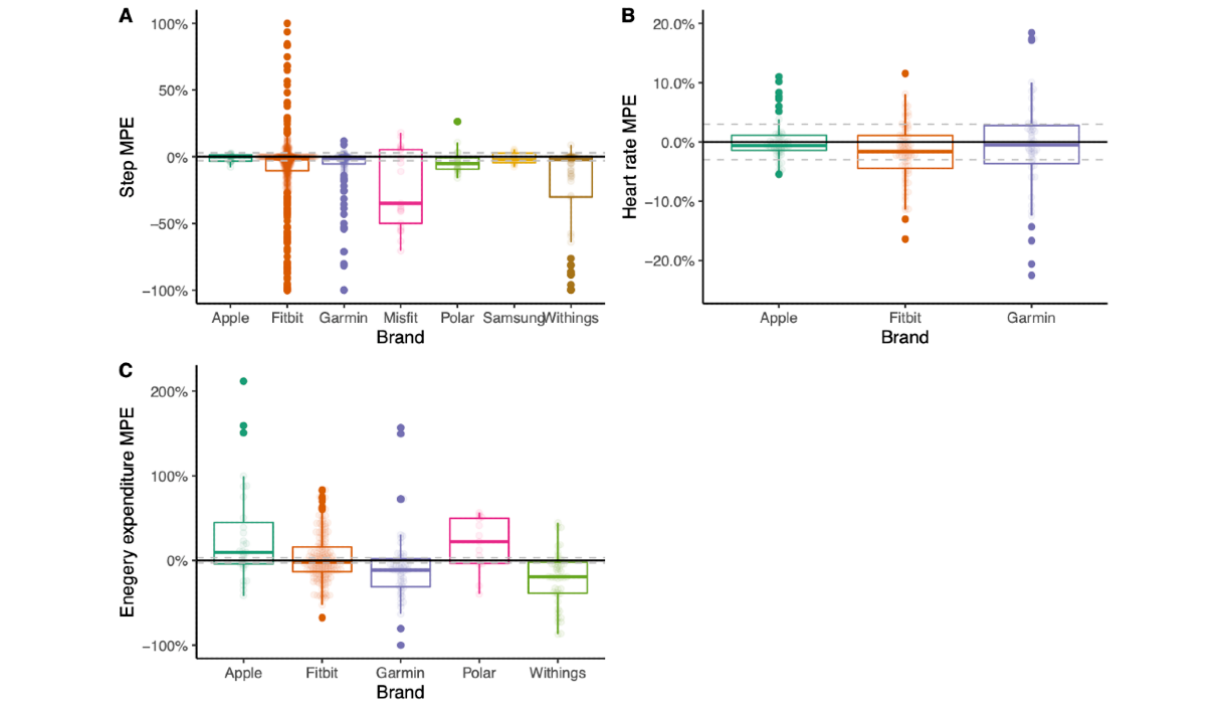
Figure 5. Box plots representing mean percentage error (MPE) for steps, heart rate, and energy expenditure by device brand for devices with 10 or more comparisons.